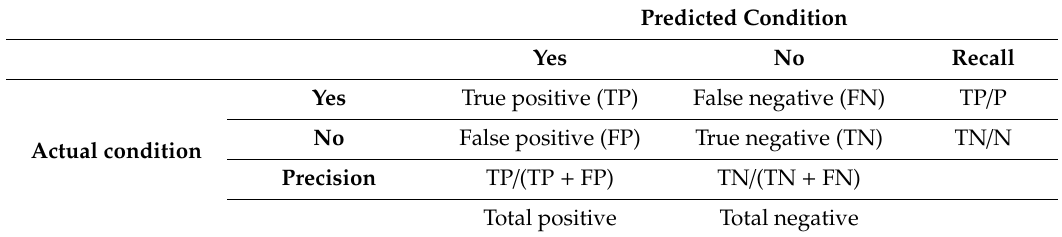
Table 2. Confusion matrix for a binary classification